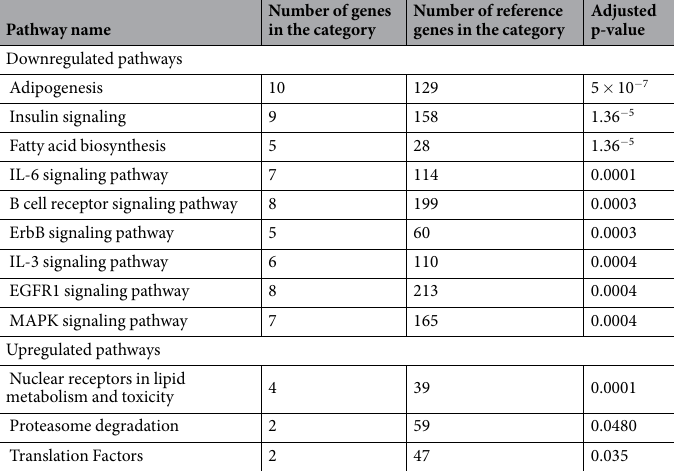
Table 1. Metabolic pathways involved in MSC-mediated conditioning based on the high-throughput RNA sequencing (WEB-based Gene Set AnaLysis